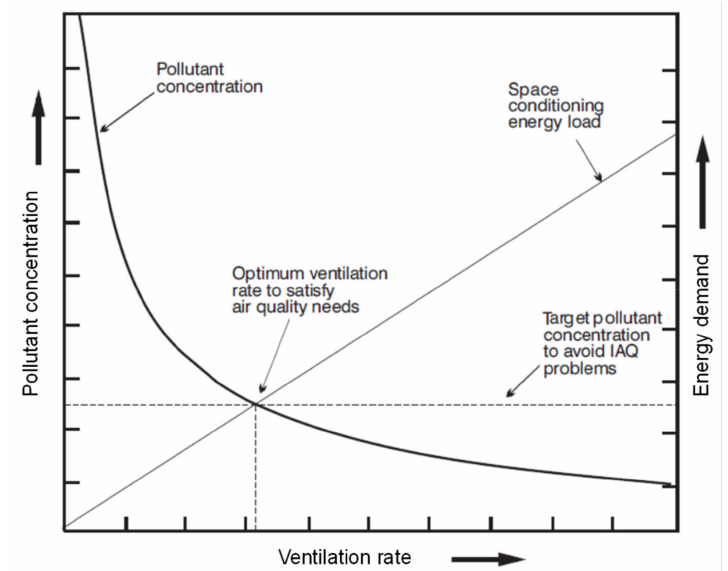
Figure 1. A qualitative connection between controlling pollutants and the energy demands of mechanical